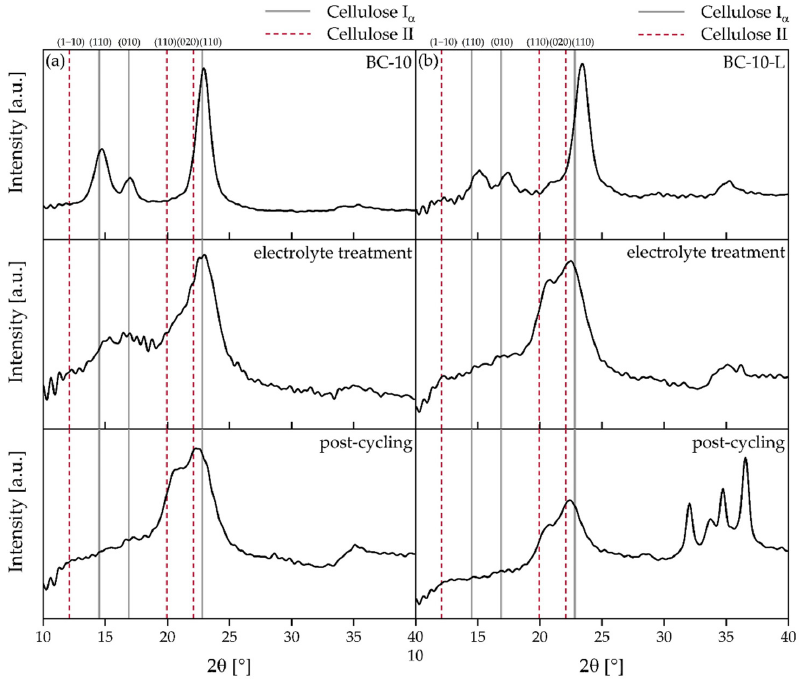
Figure 9. Diffraction patterns of the bacterial cellulose (BC) separators ( a ) BC-10 and ( b ) BC-10-L after production, electrolyte treatment, and post-cycling in a Ni-Zn